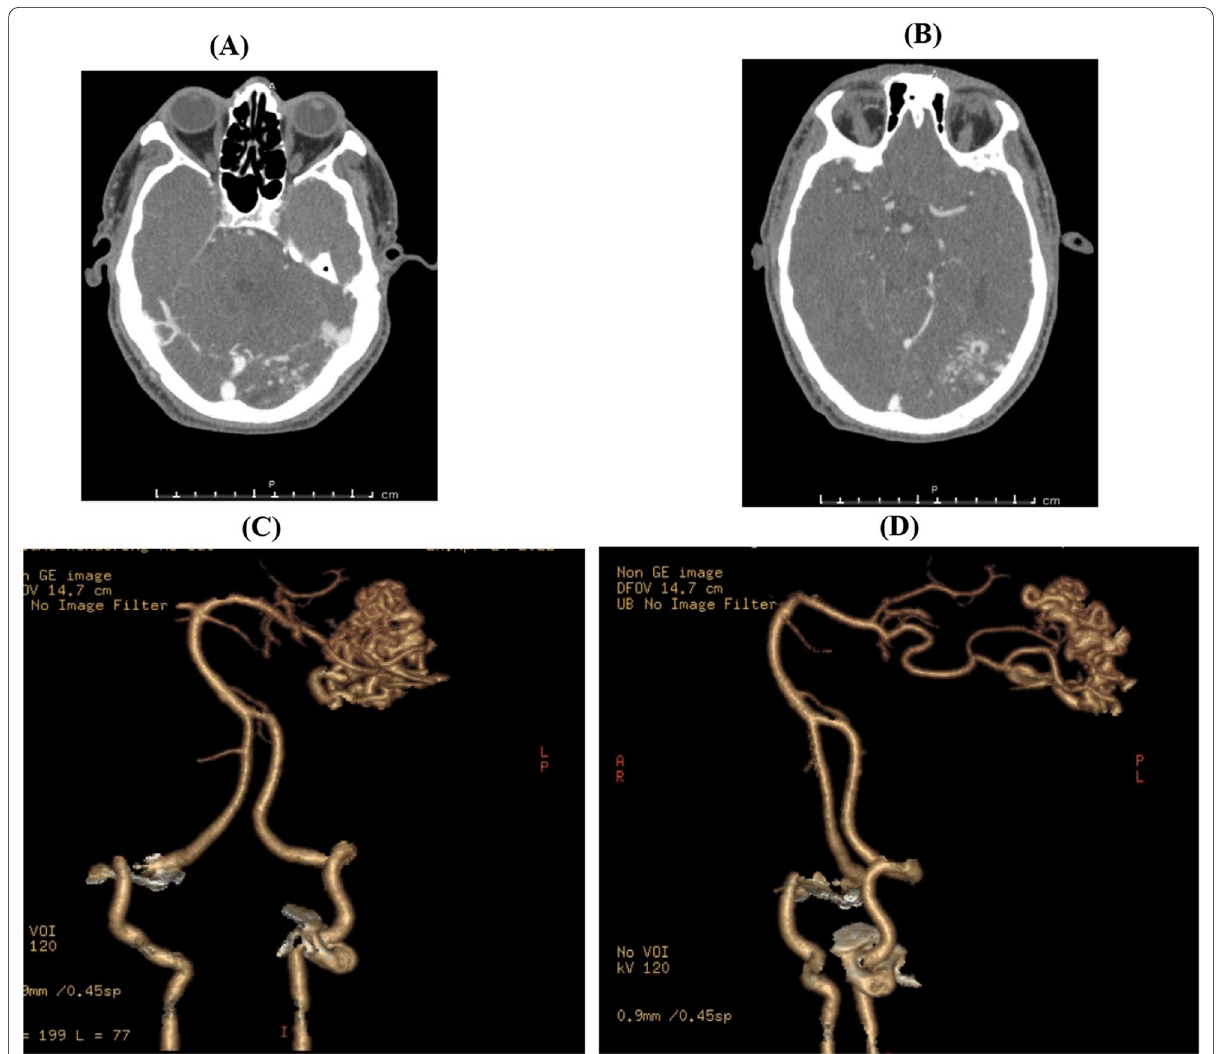
Fig. 2 CTA of AVM case. A At the level of tentorium cerebelli. B At higher level. C CT3D—AP view. D CT3D—lateral